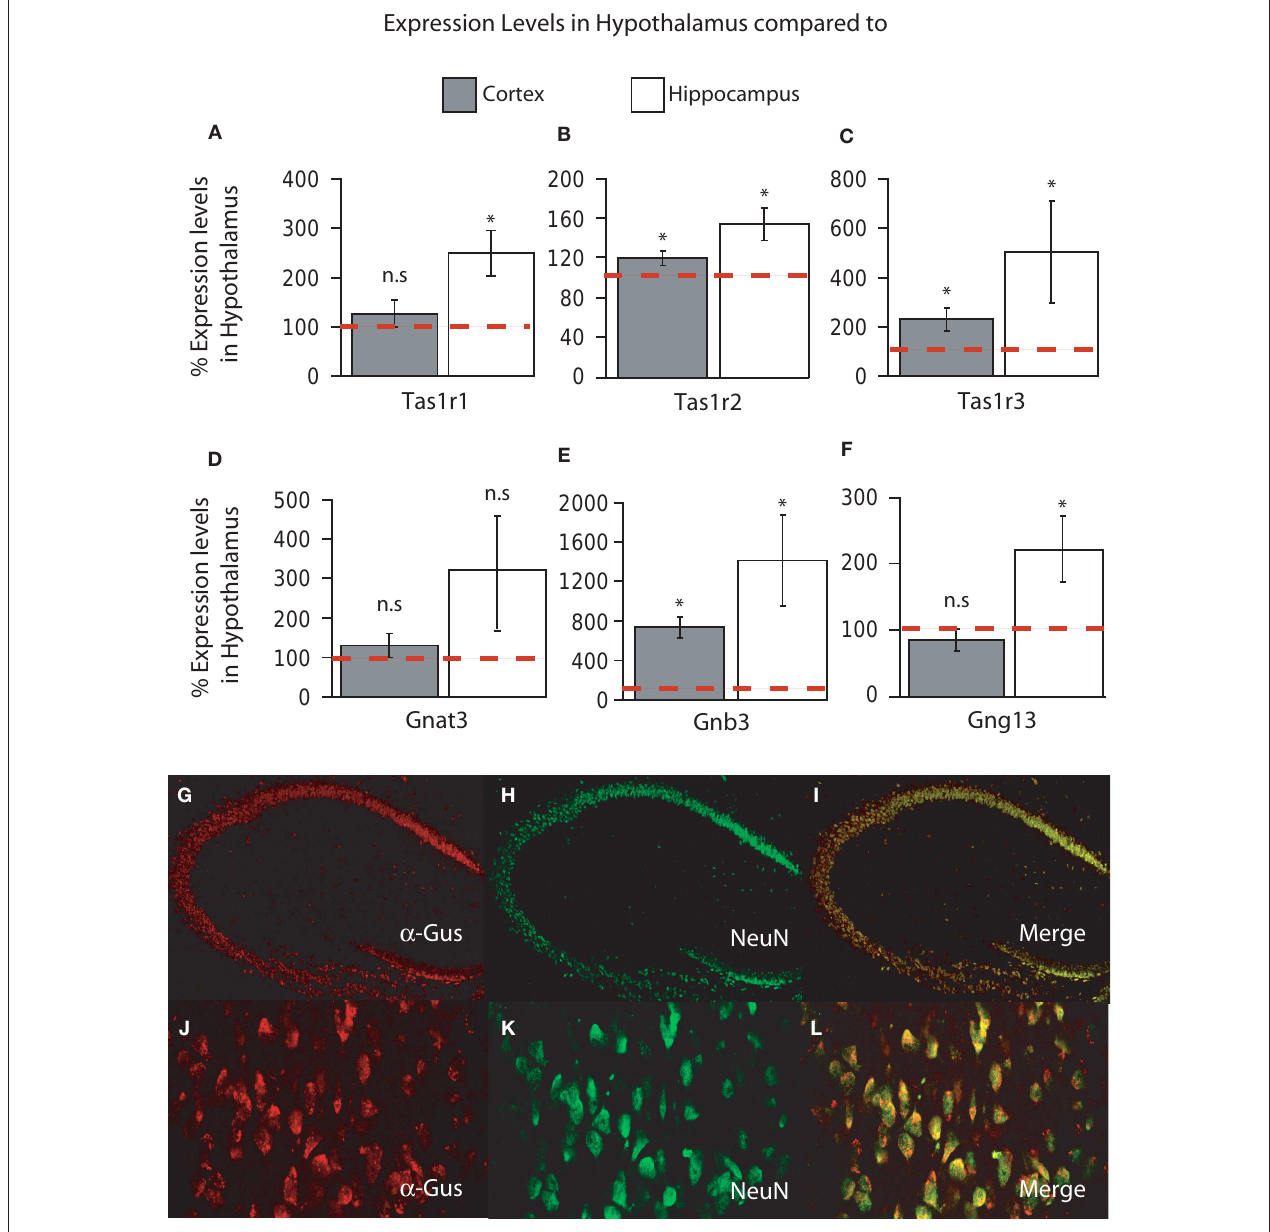
Tas1r1, Tas1r2 and Tas1r3 , respectively. (D–F) Relative levels for taste G-protein- related genes Gnat3, Gnb3 and Gng13 , respectively. Note that, overall,